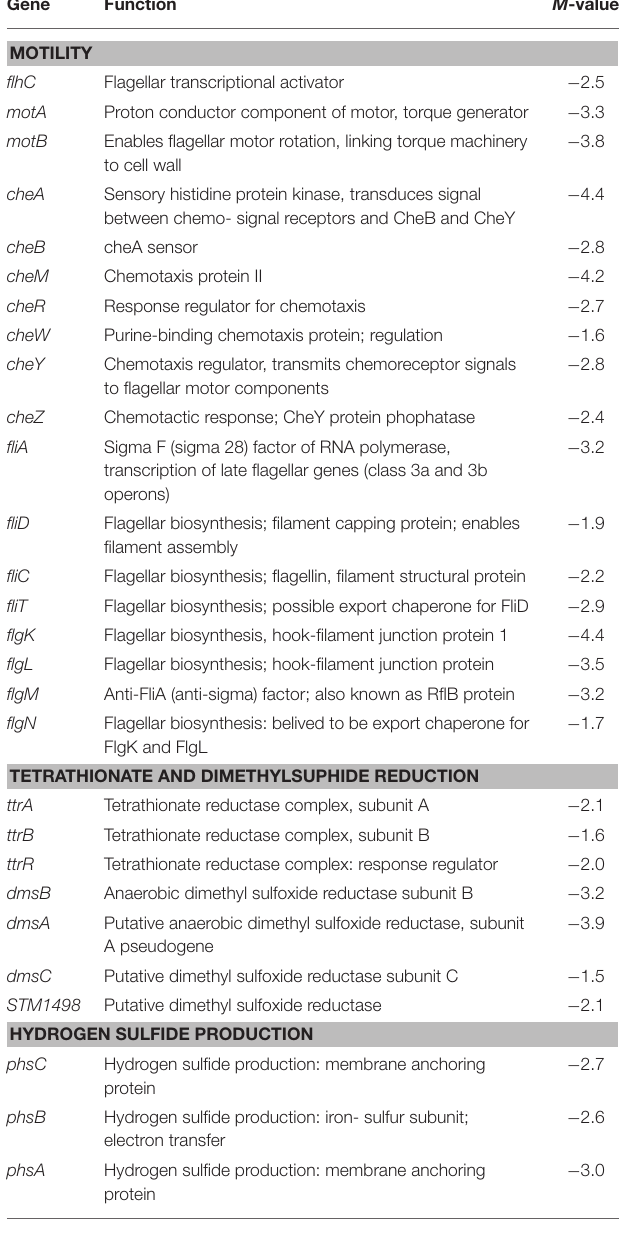
TABLE 2 | Select genes predicted to be differentially regulated in PT8 exposed to SICs of TC but not EG ( P < 0.005, M ± 1.5), based on the microarray data.